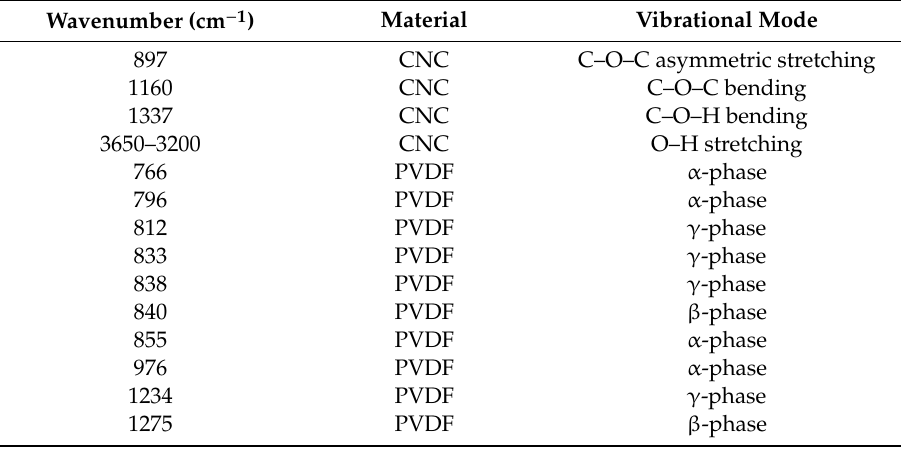
Table 1. Specific vibration modes characteristics of PVDF and CNC.